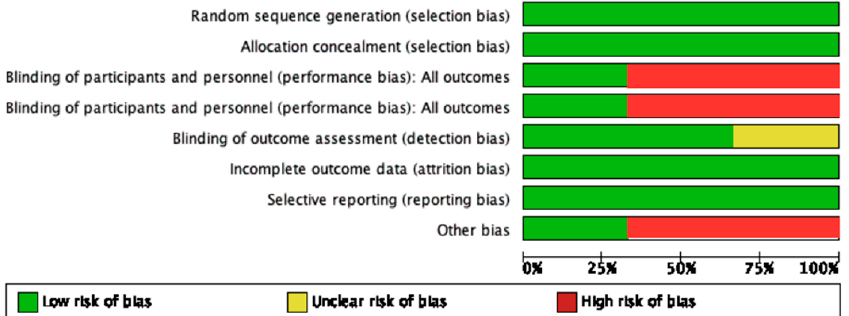
Figure 2 . Summary of risk of bias. Figure 2. Summary of risk of